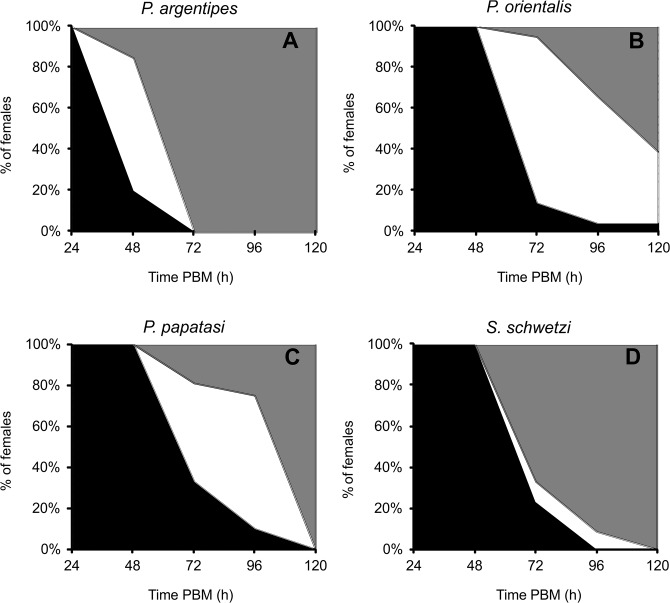
Timing of the peritrophic matrix (PM) breakdown and defecation of bloodmeal remnants in P. argentipes, P. orientalis, P. papatasi and S. schwetzi.Bloodfed females were dissected at 24, 48, 72, 96, and 120 hours PBM and checked for the localization of the bloodmeal and formation of the PM. Black area: females with bloodmeal enclosed inside the PM, white area: females with the PM broken or fully degraded where the bloodmeal is in contact with midgut epithelium, grey area: females after defecation of bloodmeal remnants. 5A:
P. argentipes, 5B:
P. orientalis, 5C:
P. papatasi, 5D:
S. schwetzi.